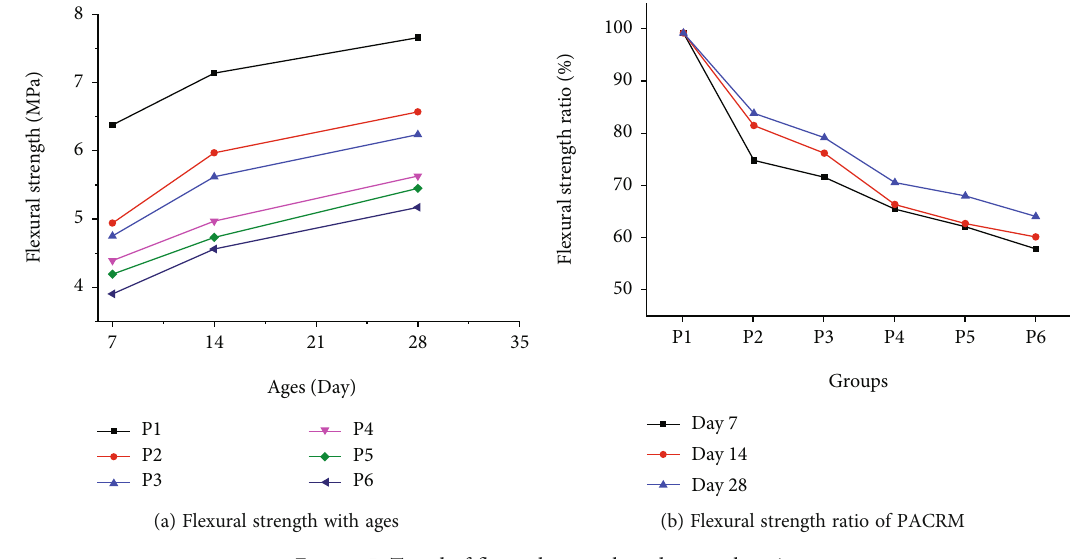
Figure 5: Trend of fl exural strength and strength ratio.